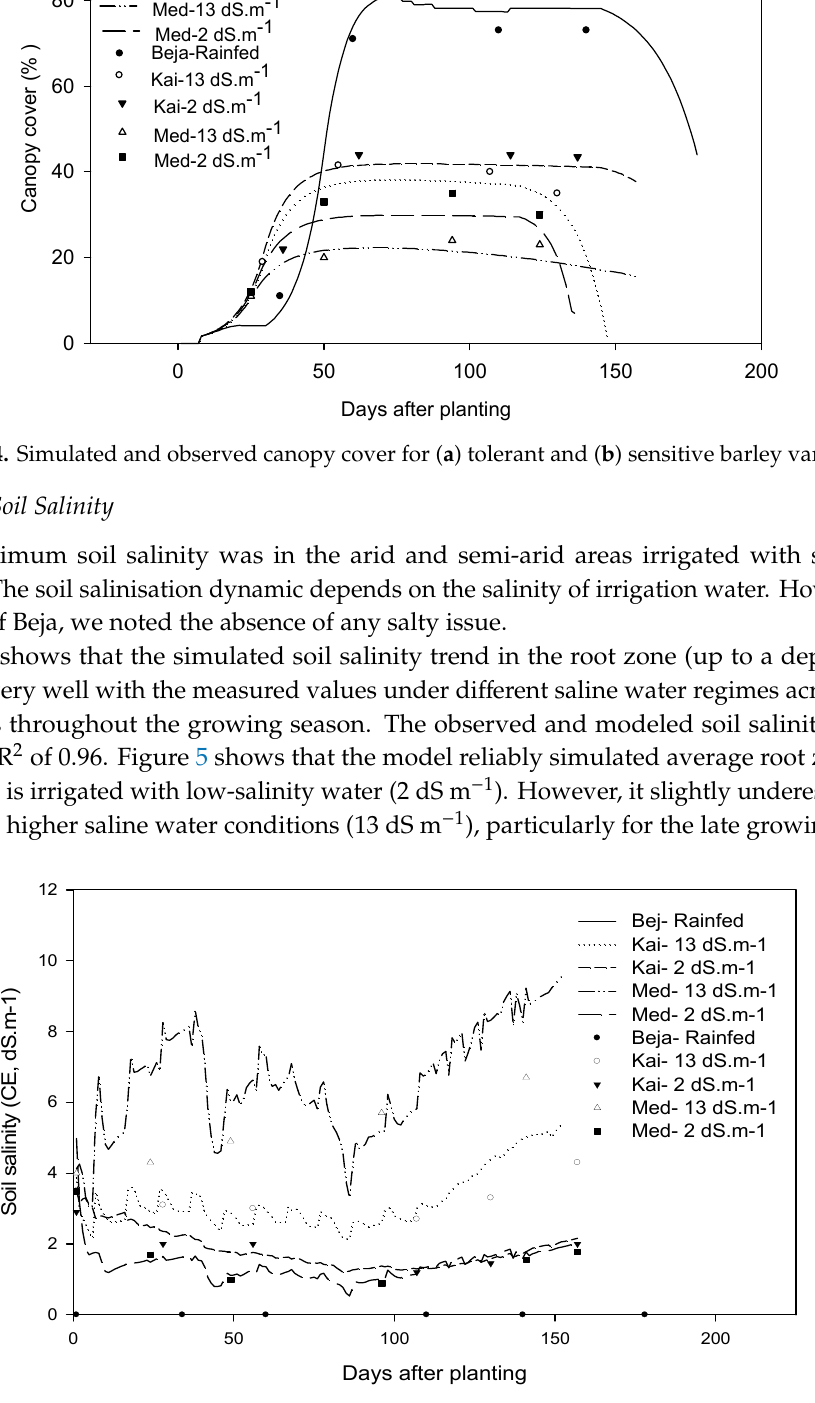
Figure 5. Simulated and observed soil salinity in the testing-cropping season under different saline water regimes and across different environments.